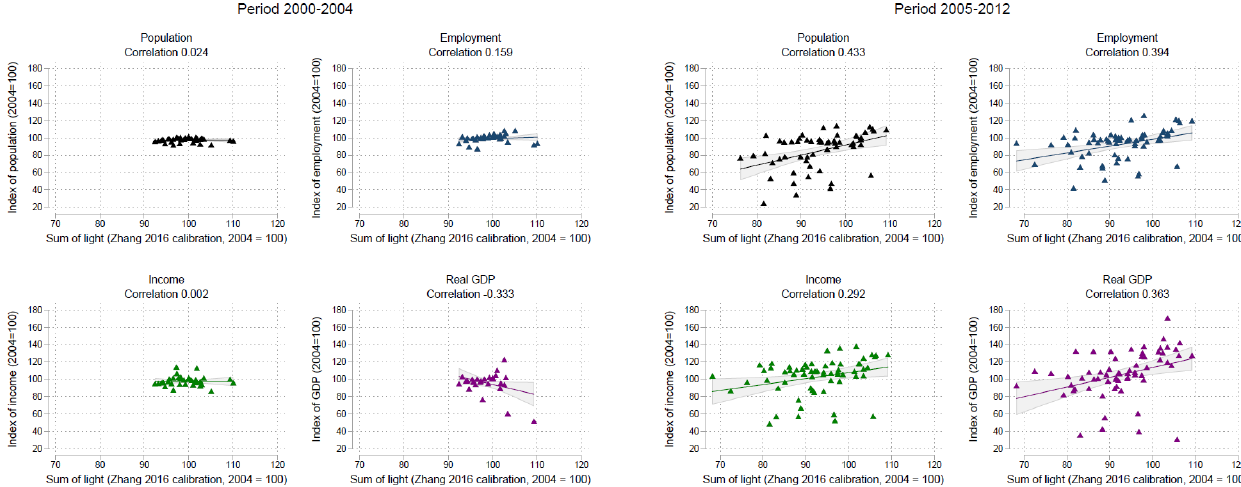
Figure A7. Indexed economic indicators and total sum of light for the eight affected counties before Katrina. Correlations of economic indicators and night lights (Zhang calibration). Night lights based on Zhang et al. (2016) calibration, indexed to 2004 = 100. Right panel: population data are for 2006–2012